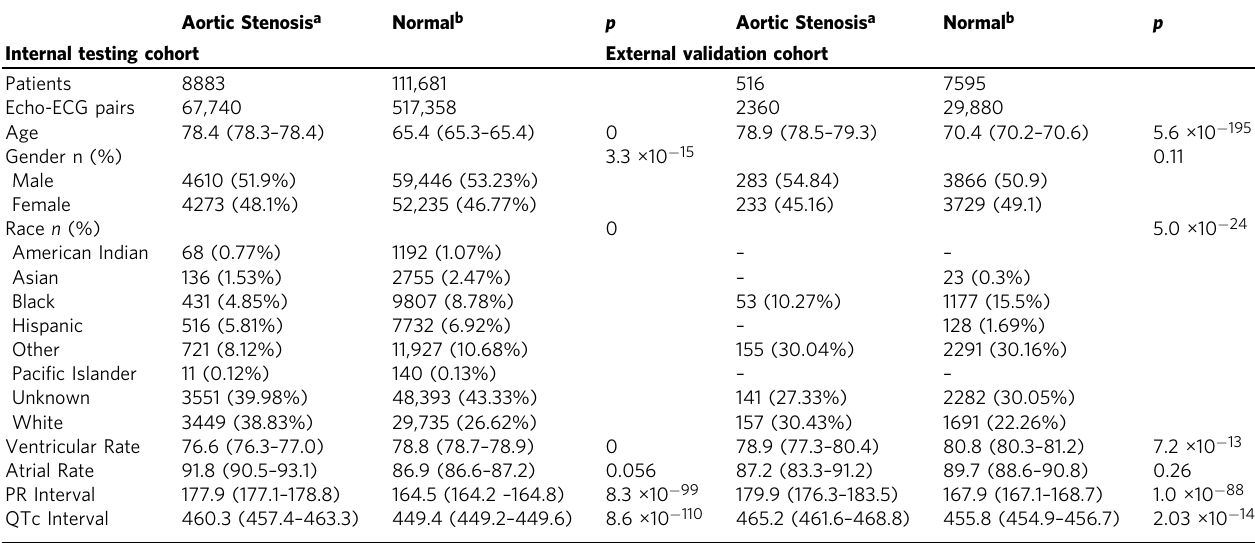
Table 2 Population metrics: patients with Aortic Stenosis (AS) in internal and external validation cohorts.